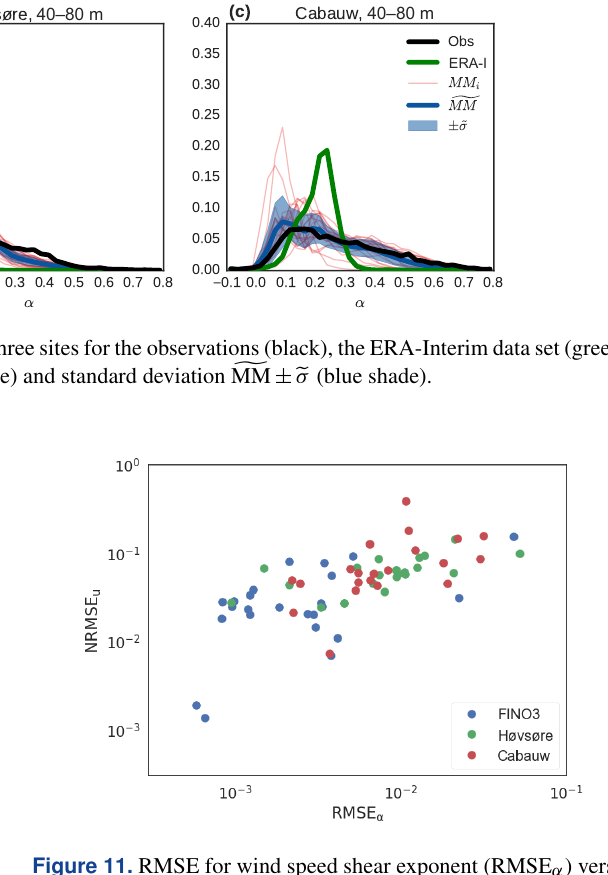
Figure 11. RMSE for wind speed shear exponent (RMSE α ) versus normalized RMSE for wind speed (NRMSE u ) at the three